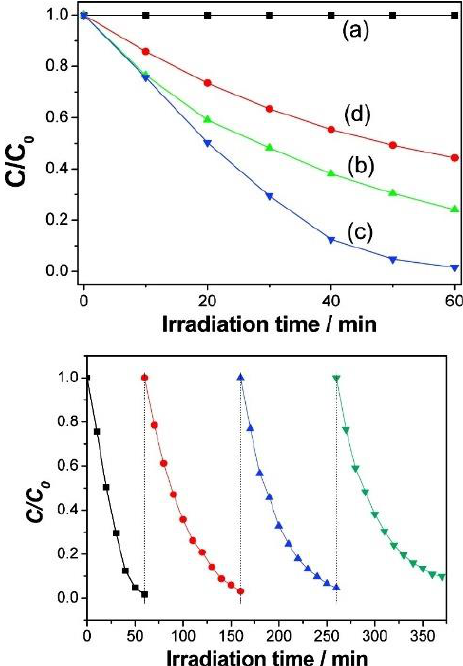
Figure 22. (Top) Comparison of photocatalytic activity and decomposition of Methyl Orange in Water of samples of (a) anatase TiO 2 (b) amorphous Ag/AgCl/TiO 2 (c) anatase Ag/AgCl/TiO 2 and (d) anatase TiO 2-x N x . (Bottom) Cyclic degradation curve for anatase Ag/AgCl/TiO 2 . Reprinted with permission from Ref [242] Copyright American Chemical Society (2009).